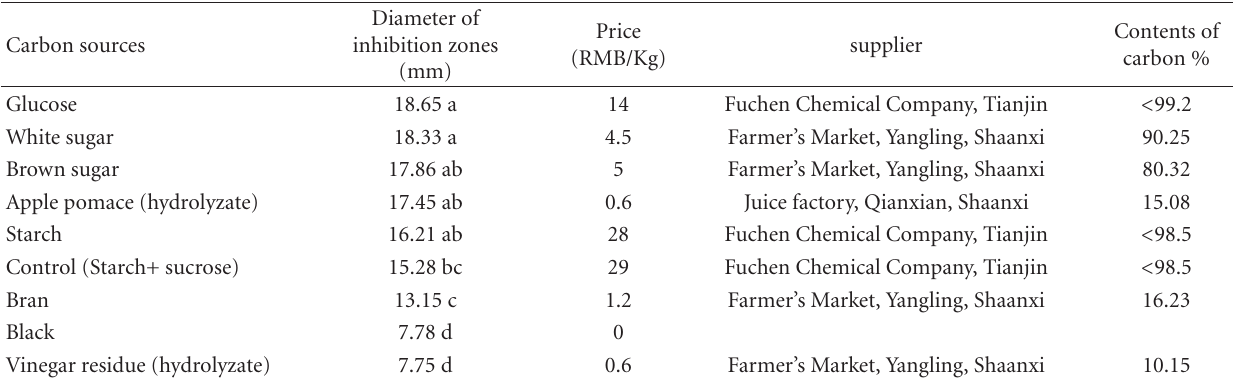
Table 1: E ff ect of various carbon sources replacing starch and sucrose in SSY medium on antimicrobial activity of strain Hhs.015 T to Candida vulgaris incubated 24 hours at 30 ◦ C on PDA medium.